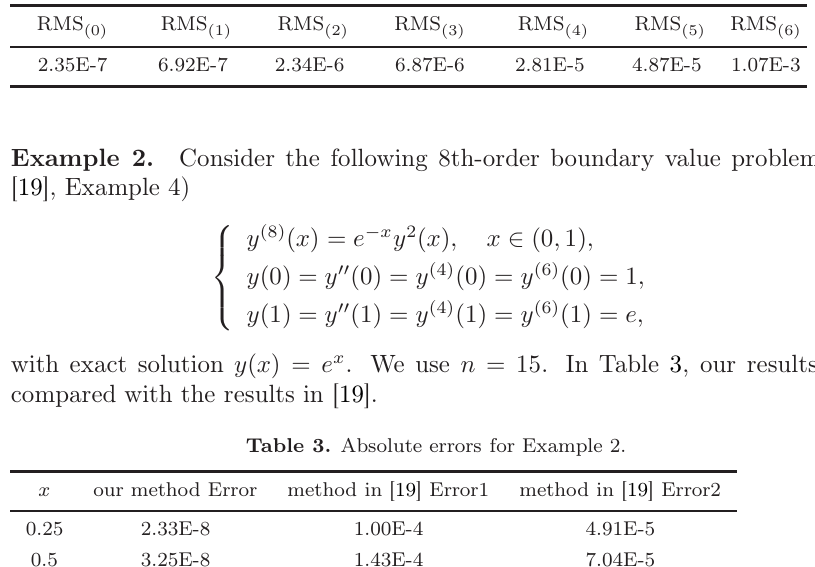
Table 2. Root-mean-square errors for example 1.Note: RMS ( i ) denote the root-mean square error of y ( i ) ,i = 0 , 1 , 2 ,..., 6 .